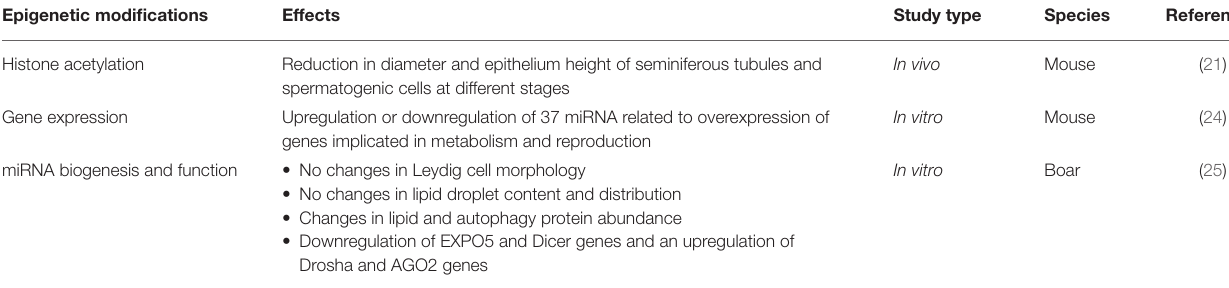
TABLE 3 | Characteristics of the studies which analyzed morphological